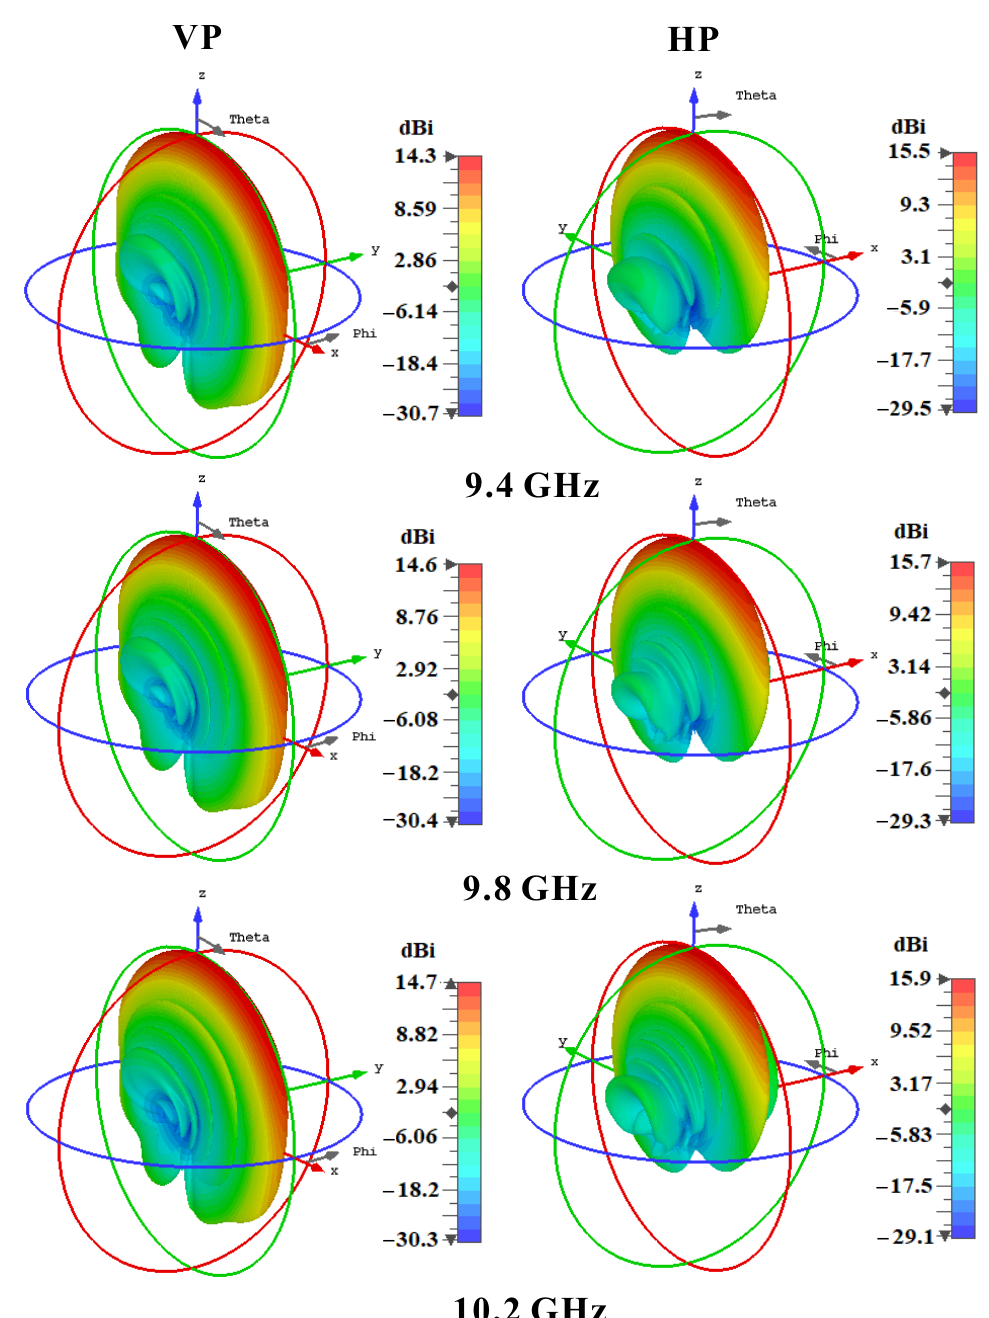
Figure 15. Simulated 3D radiation patterns of the VP and HP linear arrays at three operating frequencies of 9.4, 9.8, and 10.2